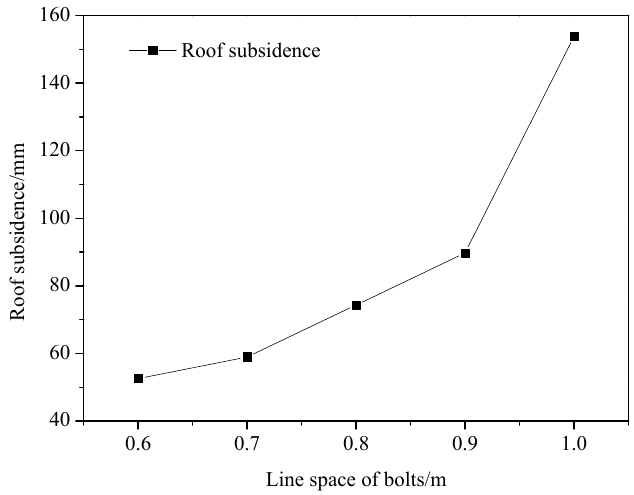
Figure 14. Variation of the roof subsidence for the roadway with different line spacing of bolts.